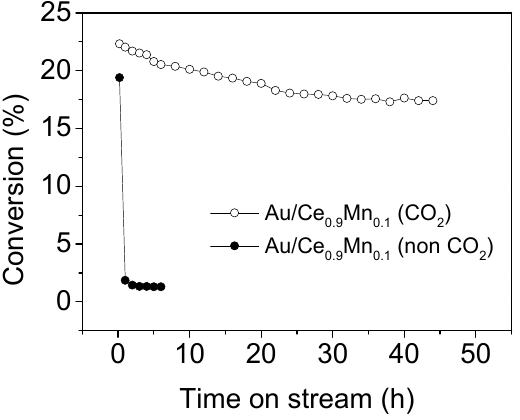
Figure 6. Ethane conversion of long ‐ term dehydrogenation of Au/Ce 0.9 Mn 0.1 in the presence and absence of CO 2 .